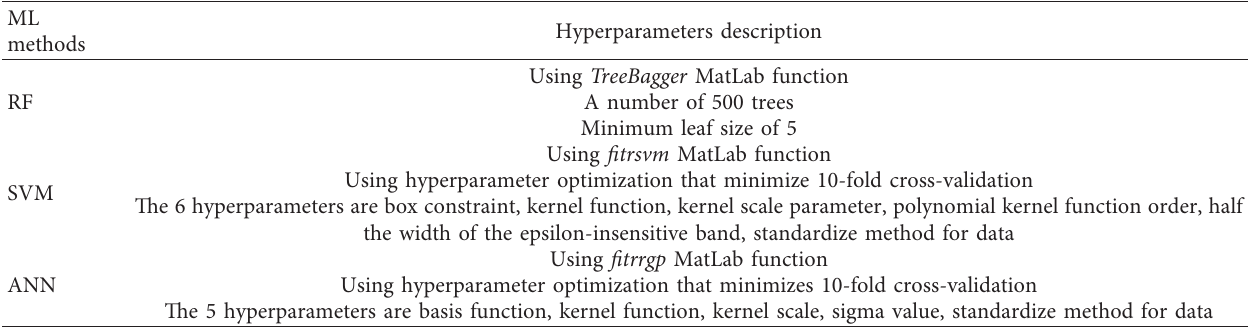
Figure 5: Histograms of the input and output variables used for the development of the RF algorithm: (a) clay content; (b) moisture content; (c) liquid limit; (d) plastic limit; (e) specific gravity; (f) void ratio; (g) soil Table 2: Hyperparameters of ML methods used in this study.